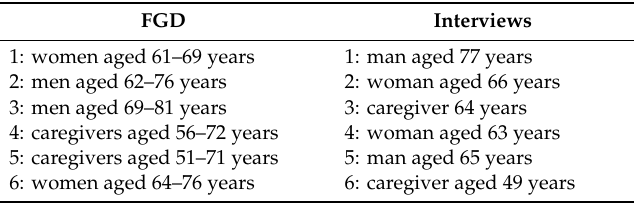
Table 1. List of